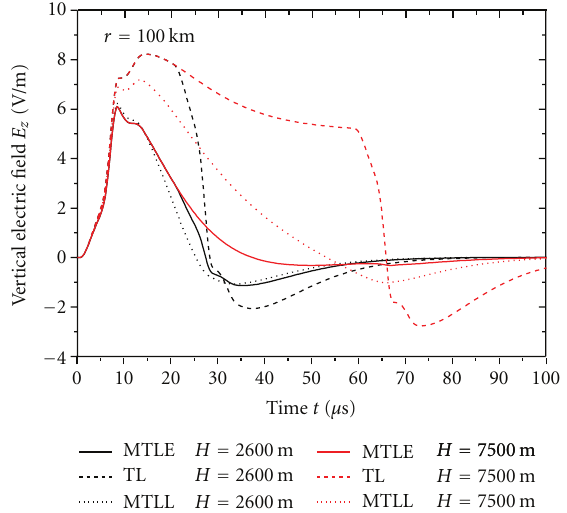
Figure 11: Azimuthal magnetic field at 5km from the channel base for NCBC, three di ff erent models and two channel heights ( H = 2600 m and 7500 m).